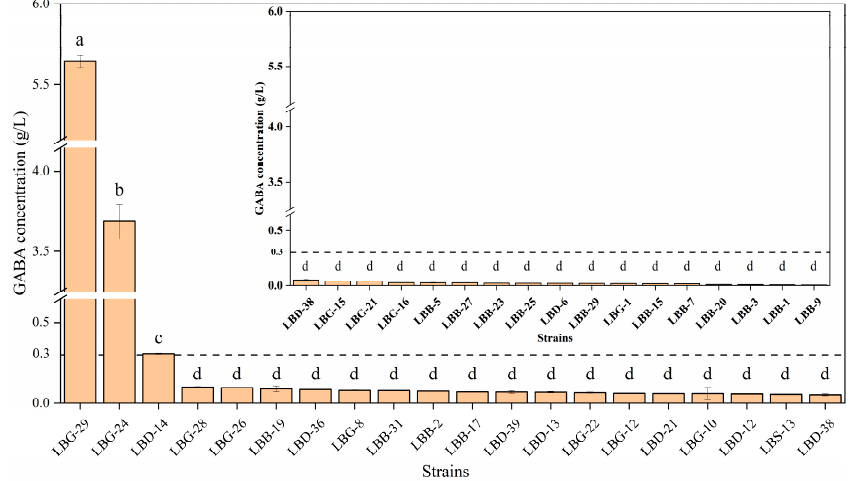
Figure 1. Production of GABA (g/L; n = 3) by the isolated lactic acid bacteria strains. Values are the means ± SD. Different letters (a, b, c, d) indicate means that are significantly different at p < 0.05.